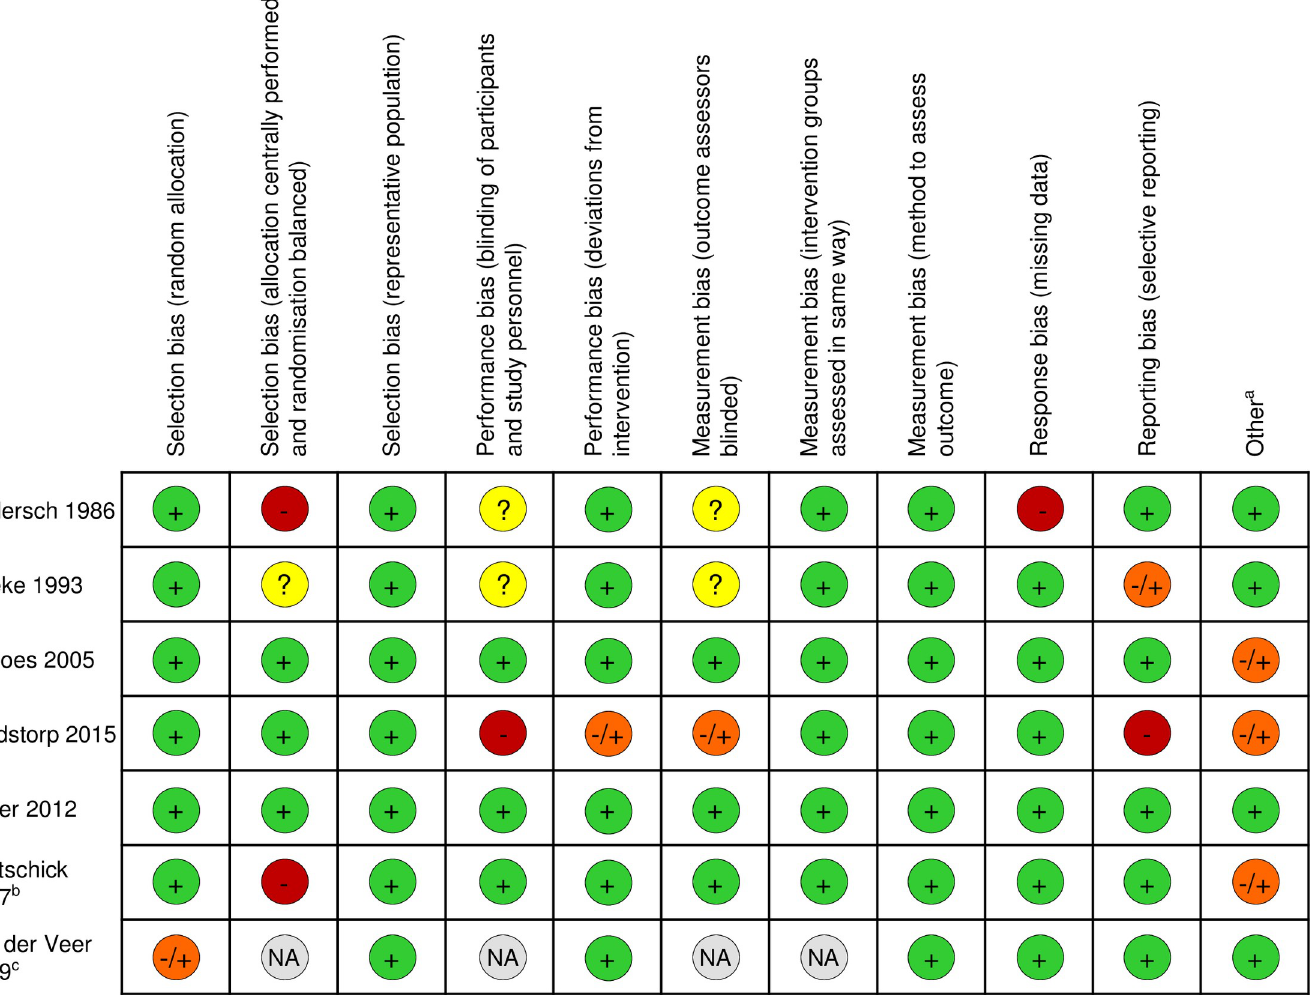
Fig 2. Risk of bias assessment. + indicates a low risk of bias, -/+ indicates moderate risk of bias,—indicates high risk of bias,? indicates unknown risk, NA indicates bias is not applicable to the study. a Other sources of bias include whether confounders were appropriately accounted for and whether lactic acid-containing product details were sufficiently described in the manuscript. b One study disclosed receipt of funding from the lactic acid-containing product manufacturer. c Single arm prospective cohort study.